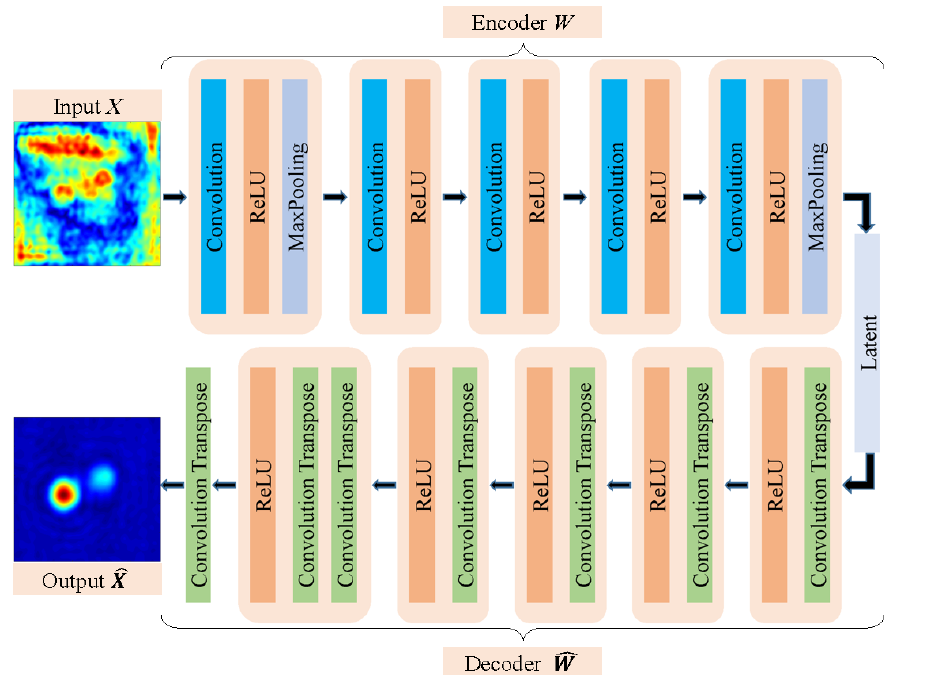
Figure 2. Architecture of an autoencoder. The input layer receives a cluttered image X and recon- structs the output target image ˆ X with the latent-space